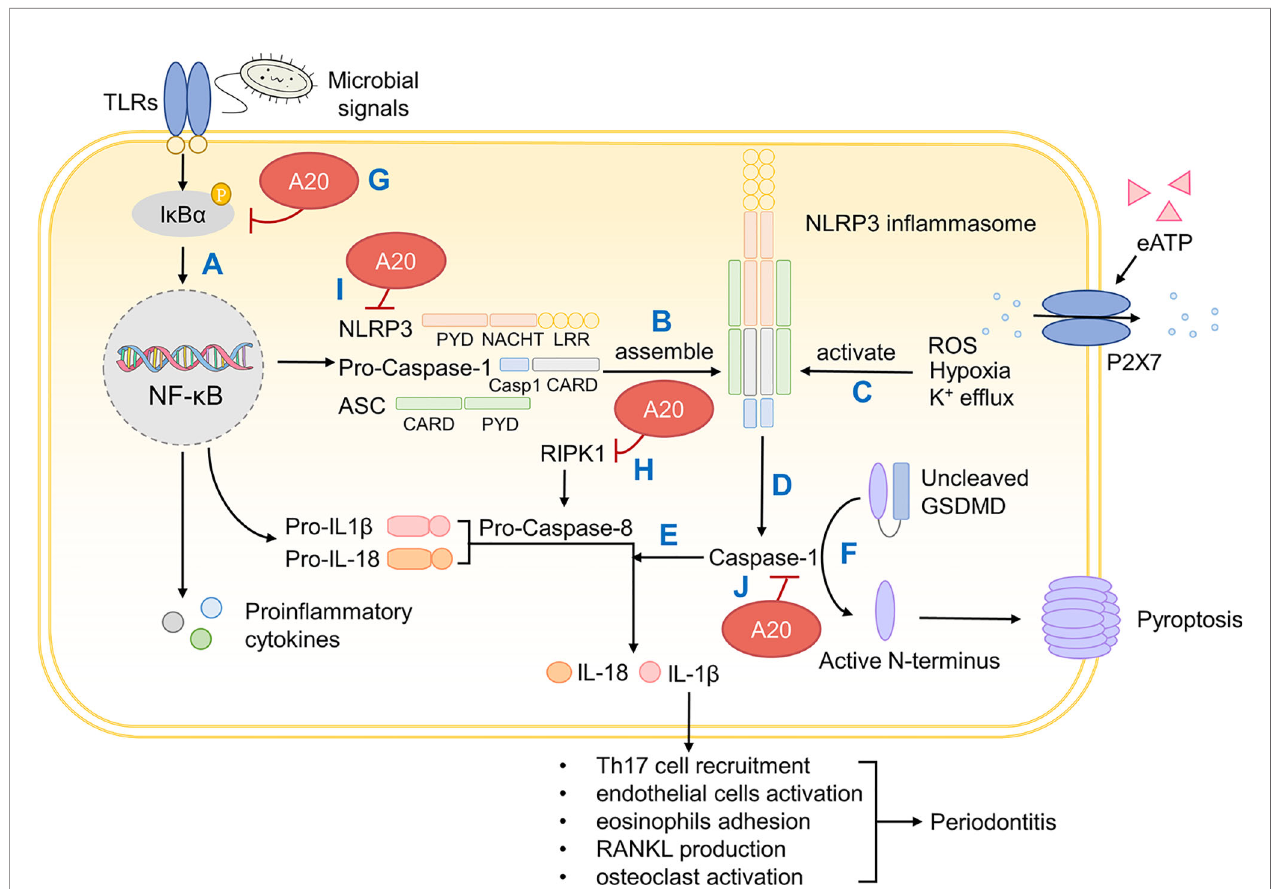
FIGURE 5 | A20 inhibits IL-1 b production and downstream periodontal in fl ammation. (A) On microbial activation, PRRs containing CARD induces pro-IL-1 b and pro-IL-18 production through NF- k B pathway. (B) NLRP 3 in fl ammasome is assembled by NLRP3, pro-Caspase-1 and ASC. (C) NLRP3 in fl ammasome is primed by microbial signals and activated by ROS, hypoxia and K + ef fl ux. (D) Mature NLRP3 in fl ammasome confers Caspase-1 with bioactivity. (E) Caspase-1 cleaves and activates pro-IL-1 b and pro-IL-18 that induces in fl ammation. (F) Caspase-1 also cleaves GSDMD whose active N-terminus forms a pore on the cellular surface and causes pyroptosis. (G) A20 inhibits NF- k B signaling through I k B a . (H) A20 degrades RIPK1, impedes pro-Caspase-8 production and thus inhibits IL-1 b production. (I) A20 restricts NLRP3 function through caspase1-caspase8- RIPK1-RIPK3 complex. (J) A20 inhibits caspase-1 dependent pyroptosis. PRRs, pattern recognition receptors; CARD, caspase activation and recruitment domain; NLRP3, NOD (nucleotide oligomerization domain)-, LRR (leucine-rich repeat)-, and PYD (pyrin domain)-containing protein 3; ASC, apoptosis-associated speck protein containing a CARD; ROS, reactive oxygen species; GSDMD, gasdermin D; I k B a , inhibitor of NF- k B alpha; RIPK, receptor-interacting protein